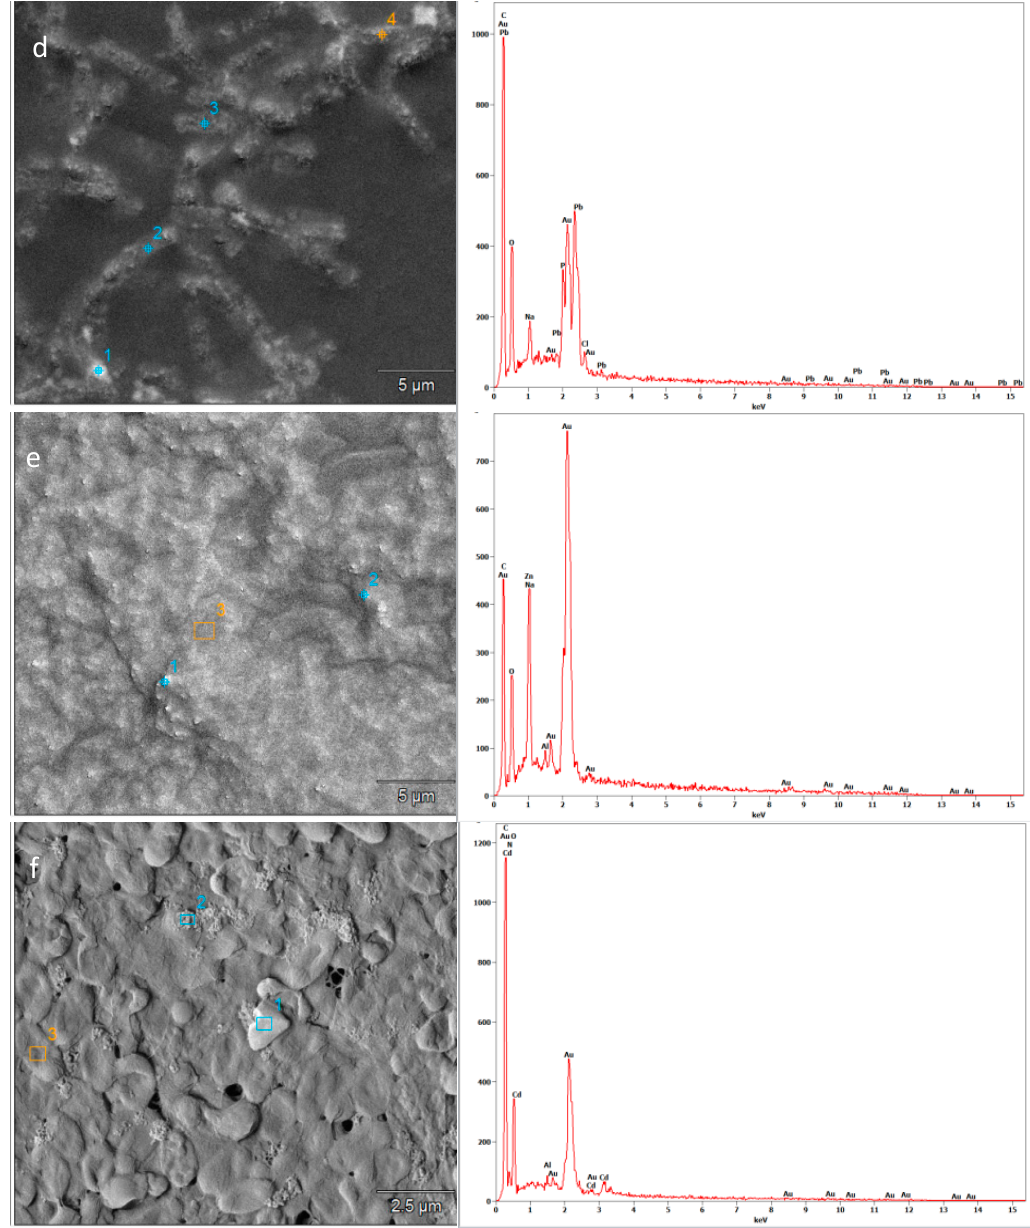
Figure 2. SEM images of bacterial colonies ( a ) B. paramycoides ST4 ( b ) B. proteolyticus ST9 ( c ) B. wiedmnni ST29 ( d ) Brevibacterium frigoritolerans ST30 ( e ) Cellulosimicrobium cellulans ST54 ( f ) Methylobacterium ST85. Numbers in blue colour follow by squares or dots represent the specific locations where EDX-spectra were taken, characterised by more electron dense (bright) metal plaques on the bacterial cells, while the orange area, is a reference location, either background or bacterial cell surface outside of a bright area. Next to each SEM image is the spectrum correspond to the location number one.